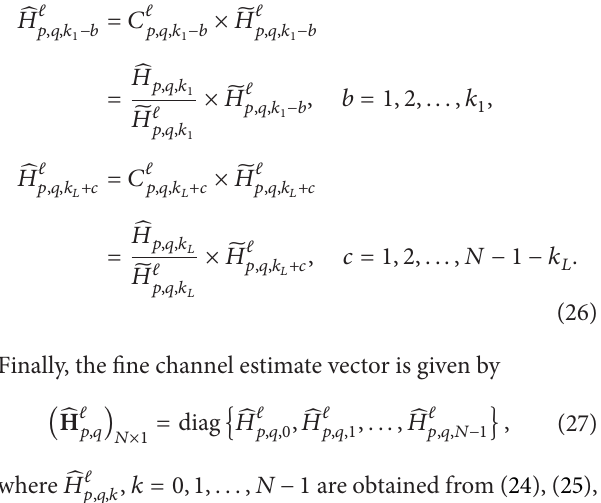
Algorithm 1: Algorithm of adaptive path number selection mech- anism for 𝐿 = 4